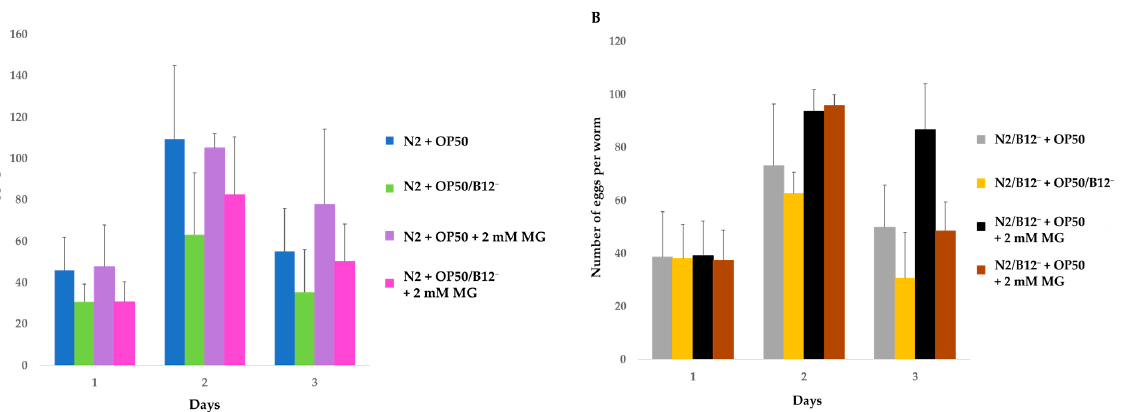
Figure 3. Average number of eggs laid by N2 ( A ) and N2/B12 − ( B ) worms in the first three days after the treatments indicated. Three independent assays were used to calculate the average number of eggs produced and the standard deviations. The Student t -test was conducted to assess the statistical significance.